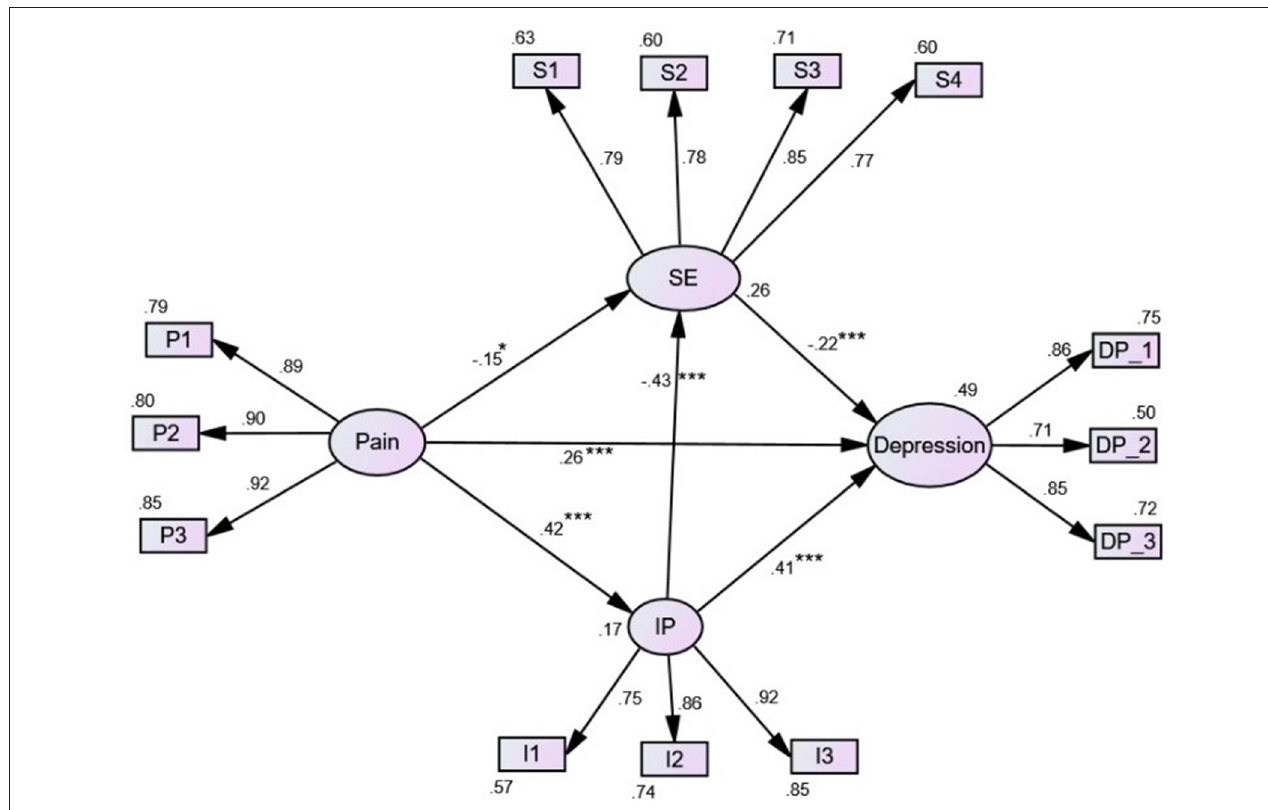
FIGURE 2 | Diagram of the SEM. IP, illness perception; SE, self-esteem. * p < 0.05, *** p < 0.001. All parameters are standardized regression